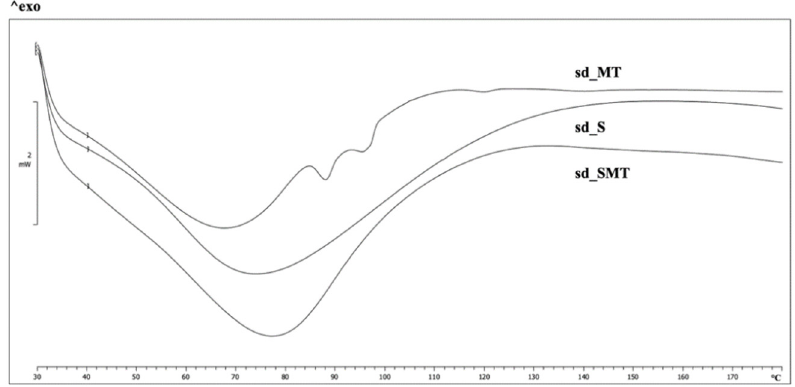
Figure 6. DSC curves of sd_MT, sd_S and sd_SMT powders.